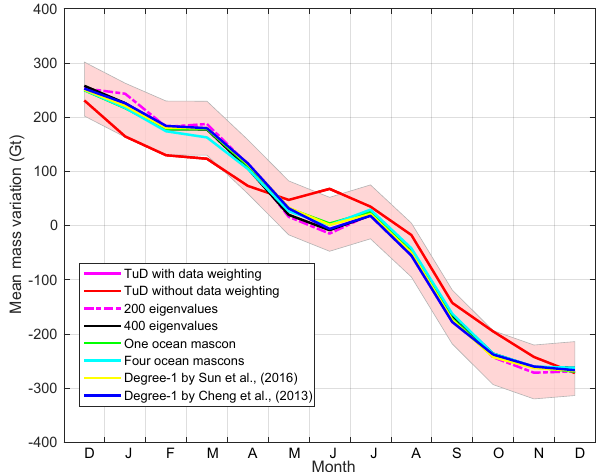
Figure A5. The mean mass anomalies per calendar month of the total–SMB residuals over the entirety of Greenland estimated from different SMB